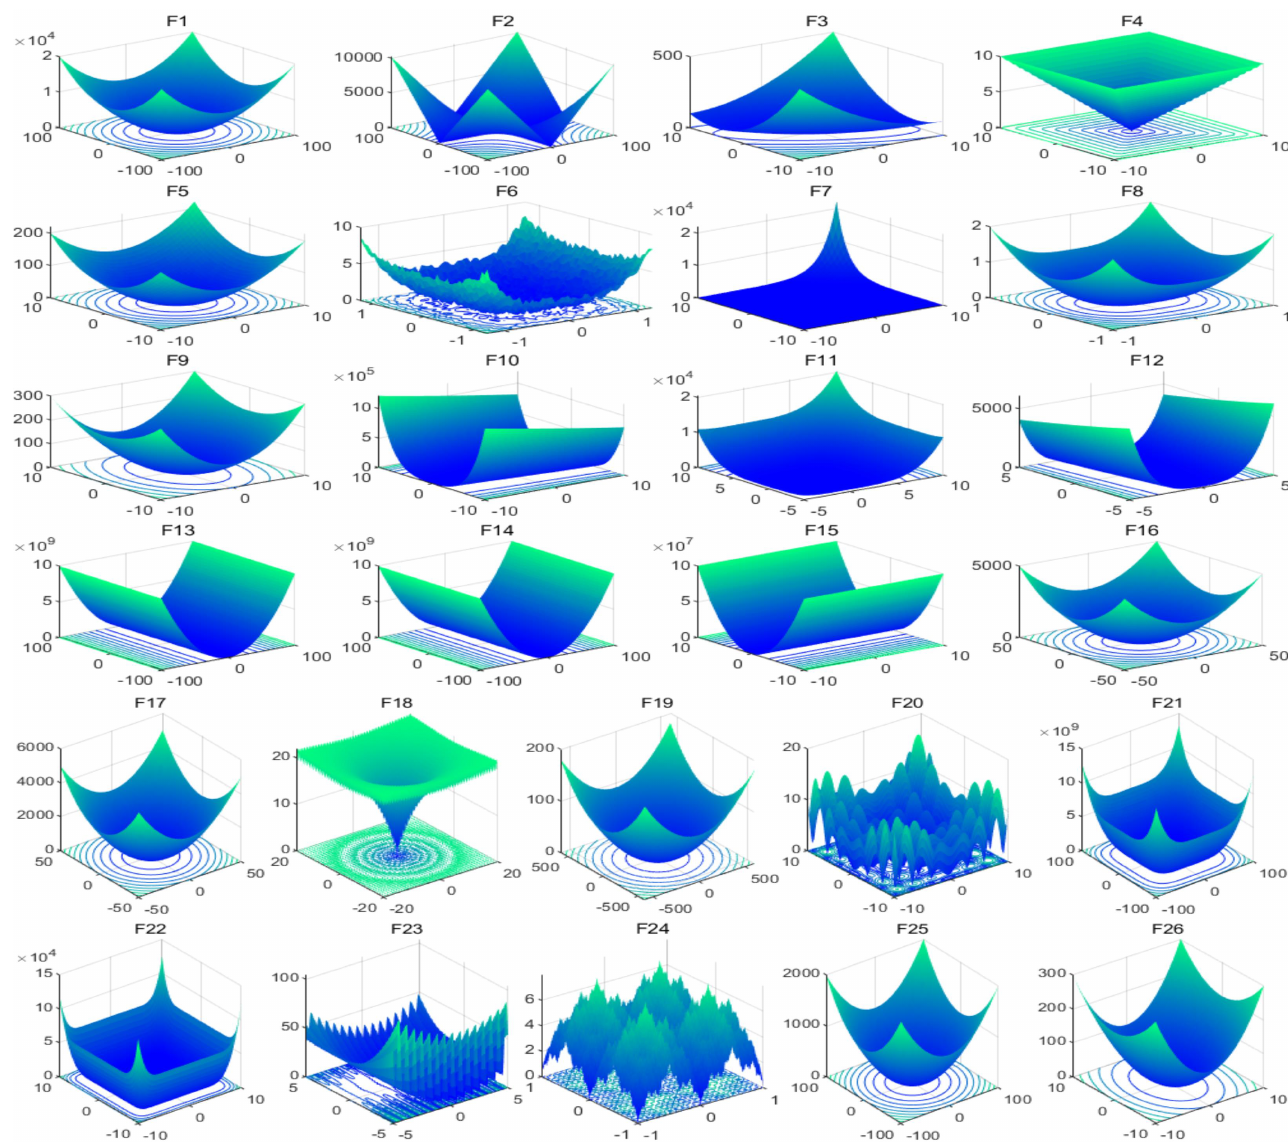
Figure 7. Search space of twenty-six benchmark